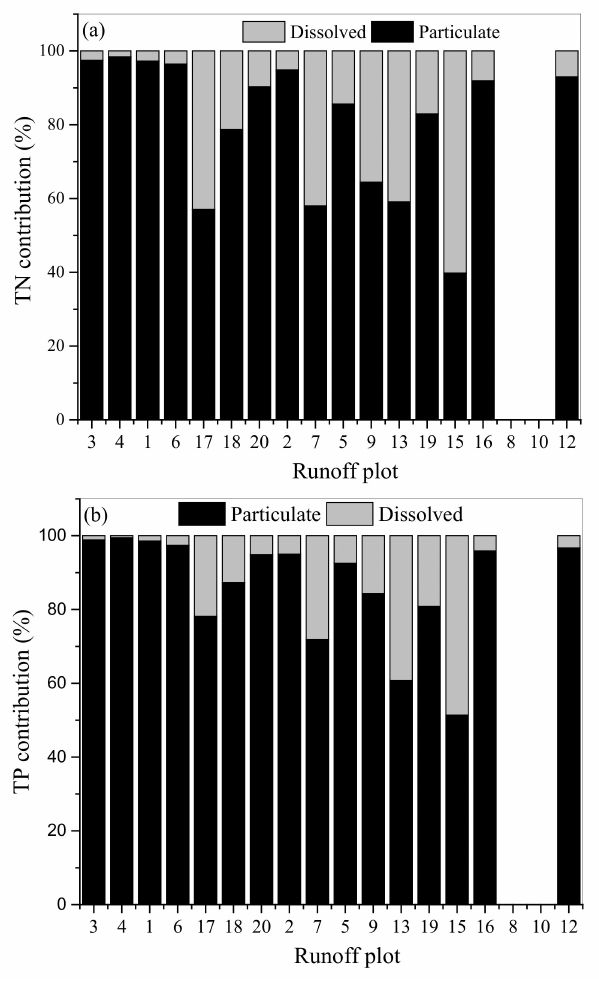
Figure 6. Contributions of the dissolved TN ( a ) and TP ( b ) in runoff and the counterparts in particulate status on the sediment to the total TN and TP losses. The numbers on the X axis represent plots. For example, the first number 3 represents Plot 3.